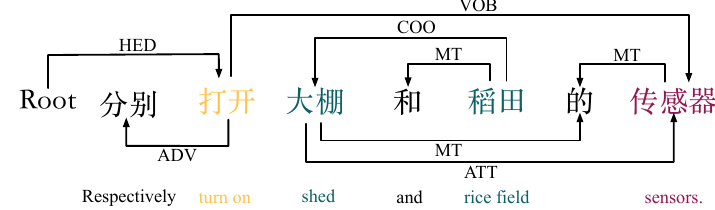
Figure 4. Example of a dependency